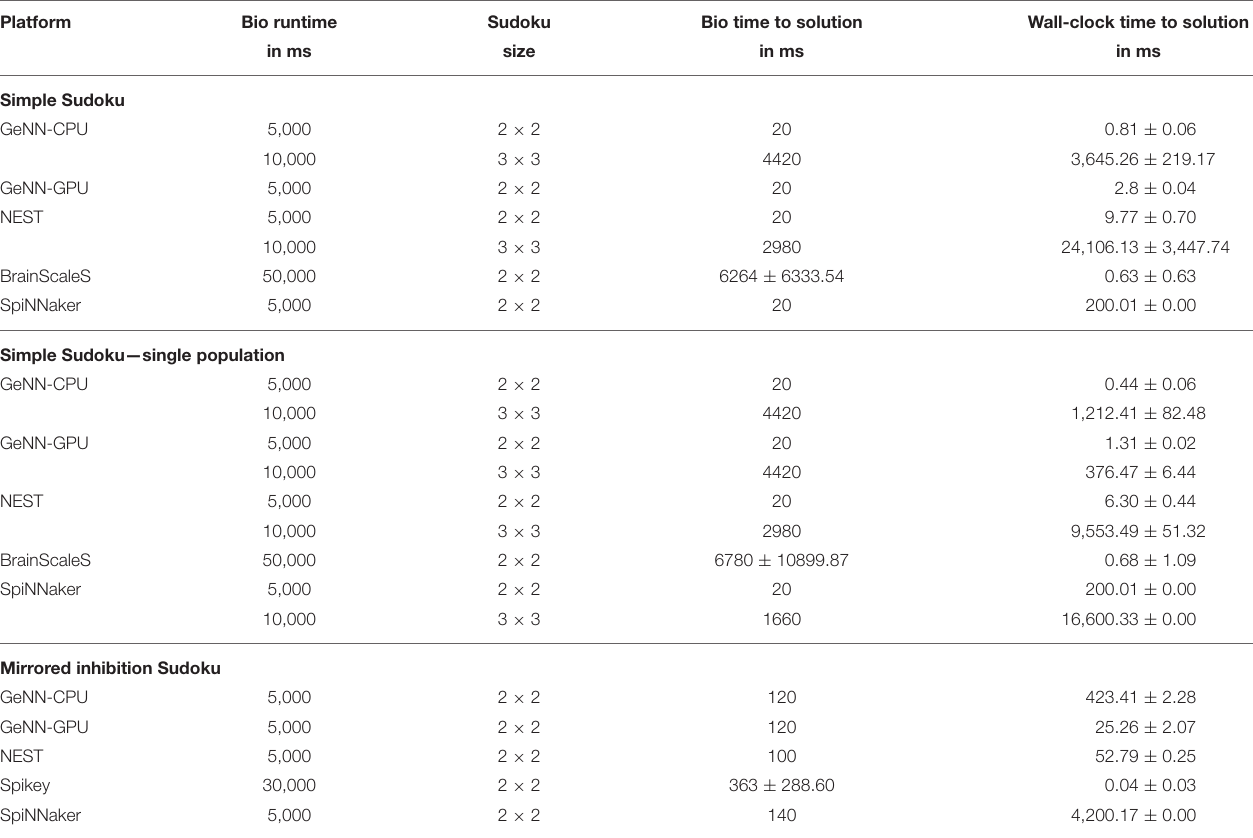
TABLE 2 | Results of the Sudoku benchmark for several implementation styles and two Sudoku sizes. Platform Sudoku Bio time to